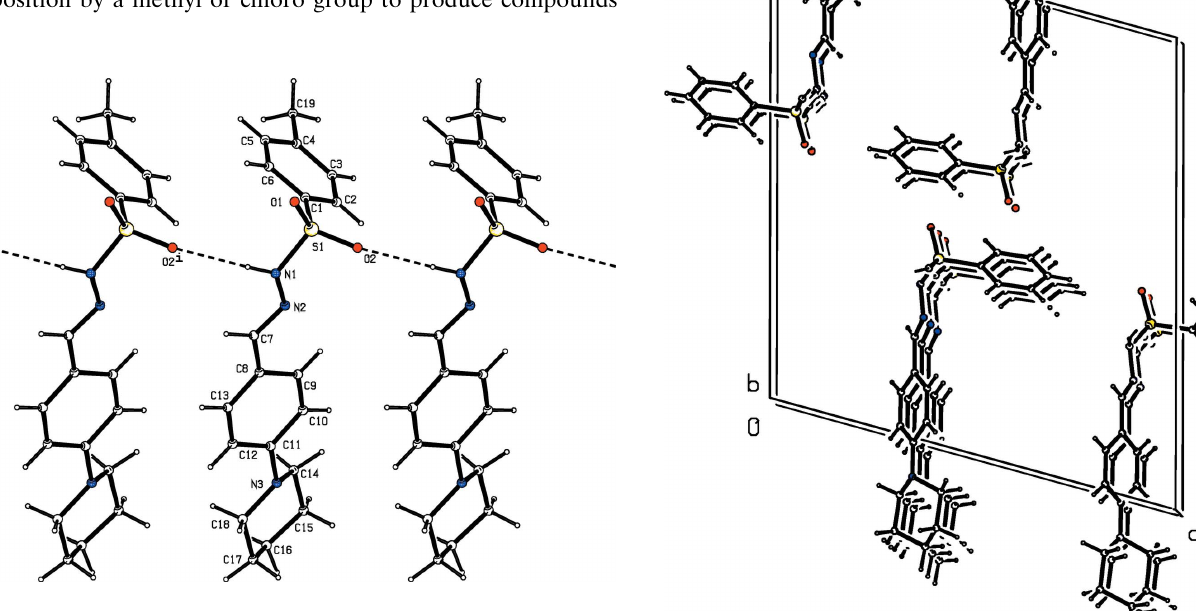
Figure 5 Hydrogen-bonding pattern in (II) with hydrogen bonds shown as dashed lines. Symmetry code as in Table 2.